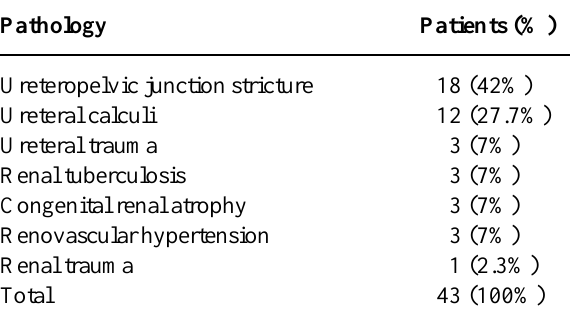
Table 1 – Etiology of the lost renal